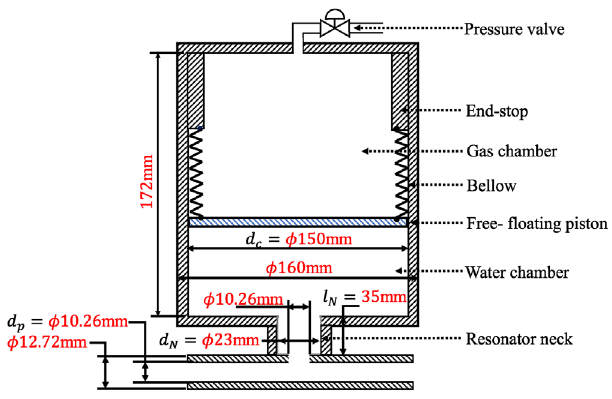
Figure 7. Cross-sectional view of of the gas resonator. Gas in the gas-cavity is separated from the water in the water-cavity by a free moving piston attached to a